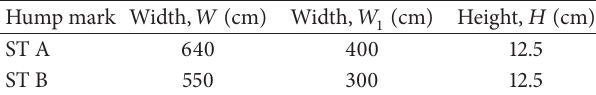
Table 1: Geometrical dimension design for speed table.